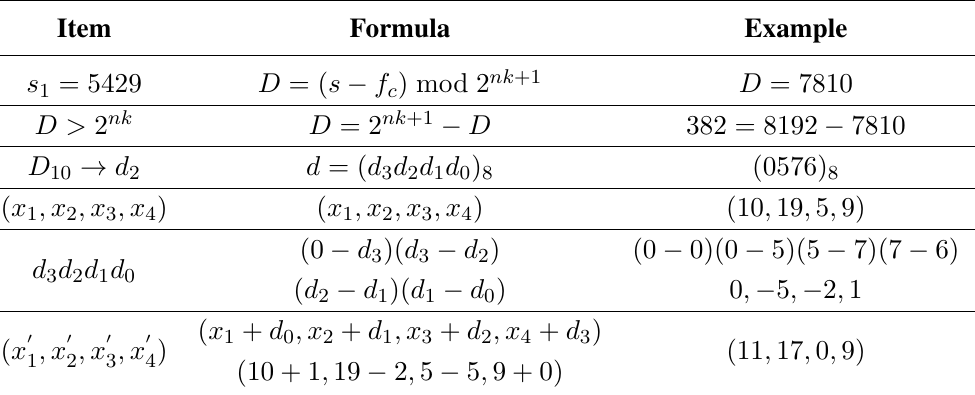
Table 1. Speeding up the embedding method when D > 2 nk .